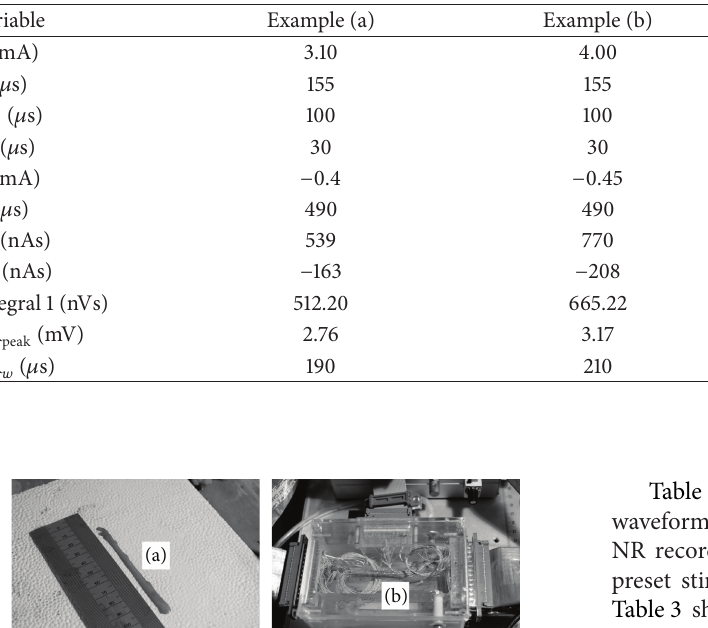
Table 3: Parameters of the stimuli and values of recorded NR.